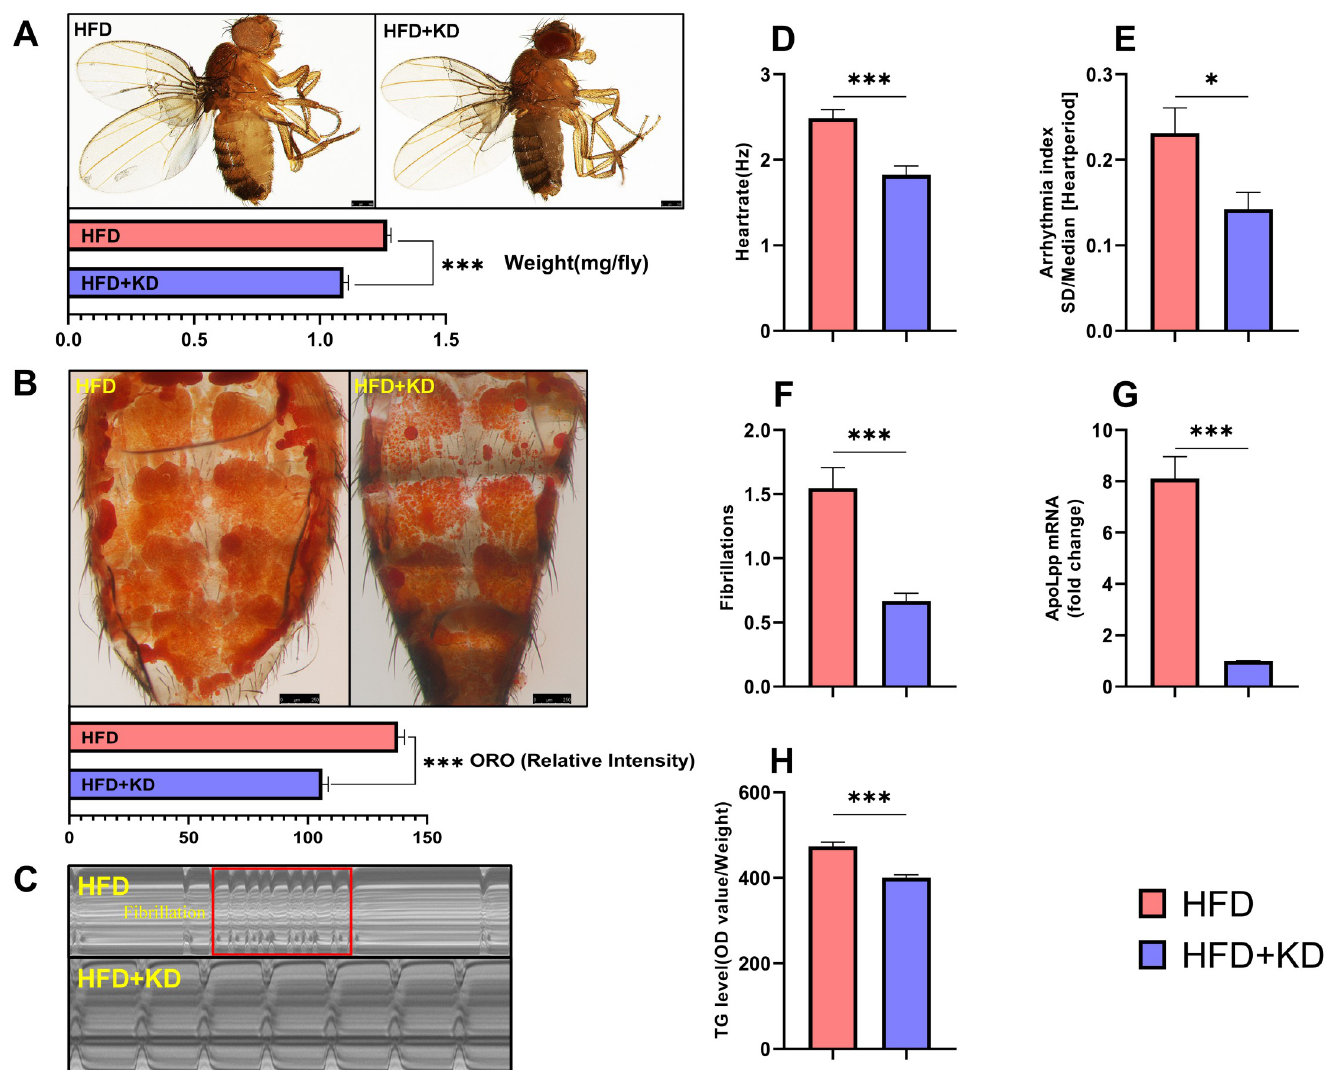
Fig 2. Under HFD feeding, inhibition of apoLpp in cardiomyocytes can reduce obesity and abnormal heart rhythm. (A) Photographs and body weights of 10-day-old flies. The body weight was obtained with an electronic microbalance, N = 15. The flies in the HFD+KD group were lighter compared to the HFD group. (B) ORO staining of the fly abdomens. Quantification of ORO intensity, N = 5. The intensity of ORO staining in the fly abdomens in the HFD+KD group was reduced, compared with the HFD group. (C) Drosophila M-mode cardiogram, the red rectangle represents fibrillation, and the interception length was 10 s (This refers to the length of the electrocardiogram of 0–10 s). (D-F) M-Mode analysis. Quantification of fly heart rate, arrhythmia index, and fibrillation, N = 30. The heart rate, arrhythmia index, and fibrillation of flies in the HFD+KD group were lower than in the HFD group. (G) The relative expression level of apoLpp in the cardiomyocytes of flies. The apoLpp in cardiomyocytes of flies in the HFD+KD group was significantly lower than that in the HFD group. The test samples included at least 60 isolated hearts. (H) Whole-body TG levels in flies. The whole-body TG level of the HFD+KD group was significantly lower than that of the HFD group. N = 5, repeated three